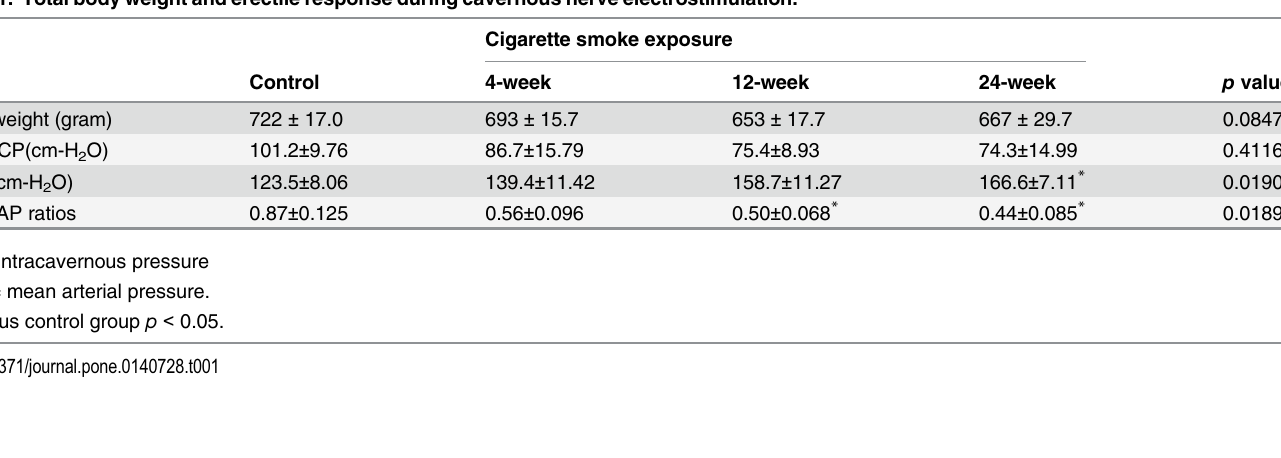
Table 1. Total body weight and erectile response during cavernous nerve